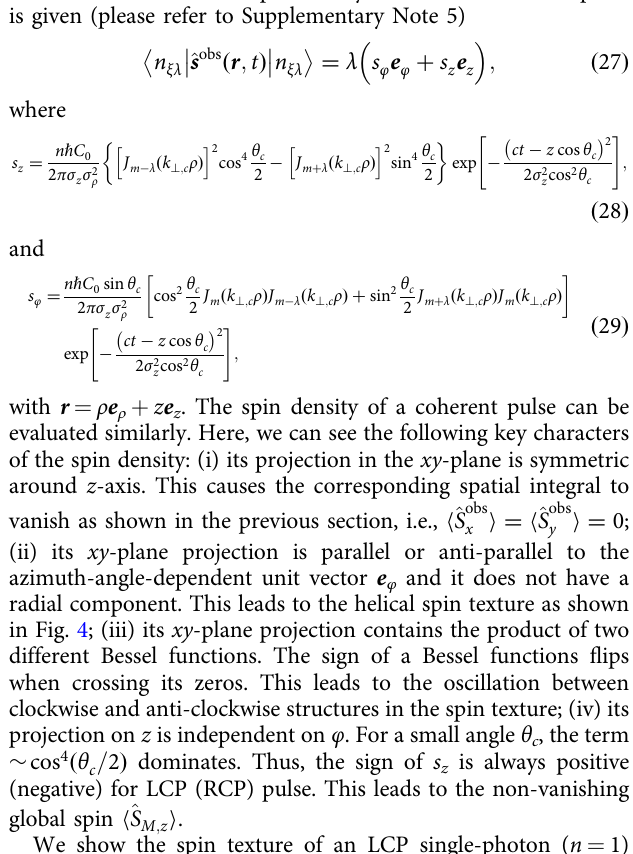
Fig. 3d. For a optical pulse, the ratio C 0 between its center wave number and its width is usually very large, e.g., C 0 ≈ 188 for a 50 fs pulse with center wave length λ c = 500 nm. In our numerical simulation, we set C 0 = 100. We note that these large OAM fl uctuations in the transverse plane also exist in traditional OAM laser beams, such as the routinely used Laguerre − Gaussian beams in